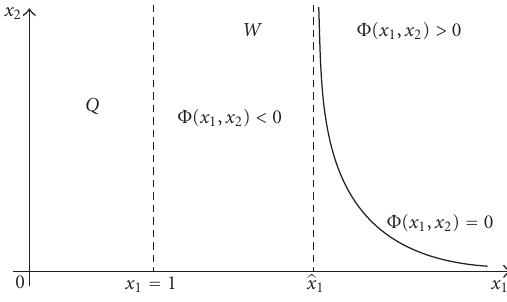
Figure 4: Allocation of signs of the function Φ ( x 1 , x 2